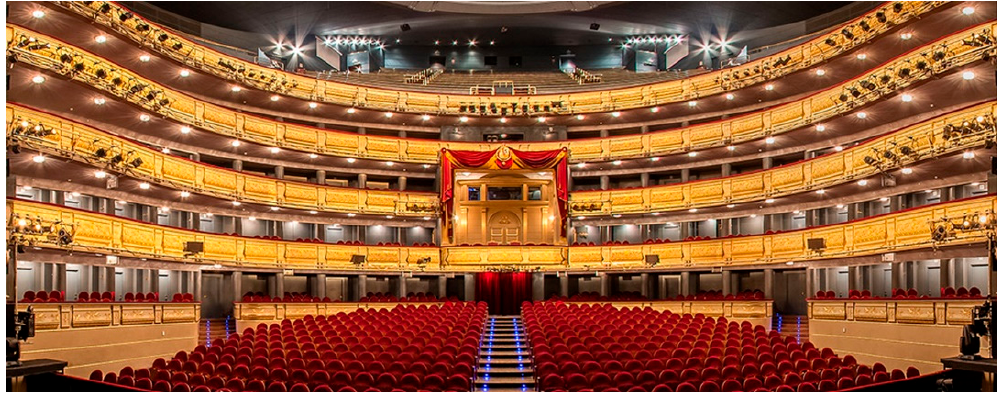
Figure 2. Teatro Real of Madrid. View of the seats.